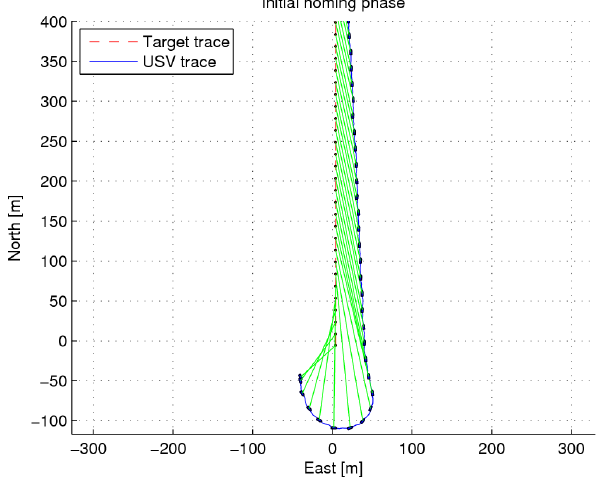
Figure 18: An alternate intercept run with less tight motion